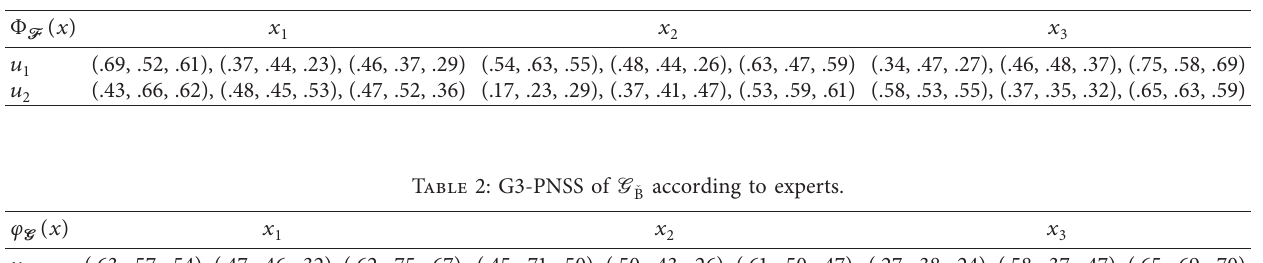
Figure 1: Flow chart of presented algorithm for GmPNSS based on the similarity measure. Table 1: G3-PNSS of F � A according to experts.